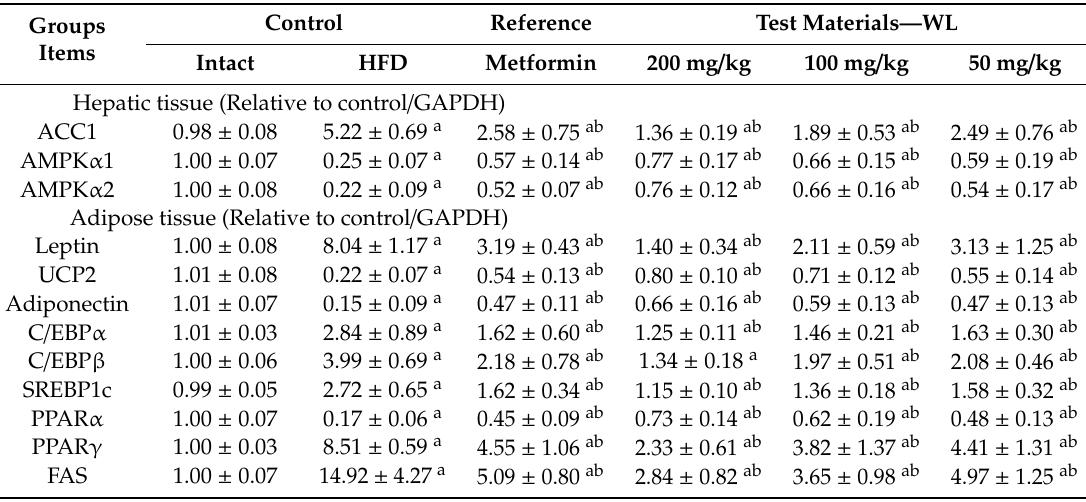
Table 16. Changes in lipid metabolism-related gene mRNA expressions in liver and adipose tissue of NFD or HFD supplied mice, realtime RT-PCR